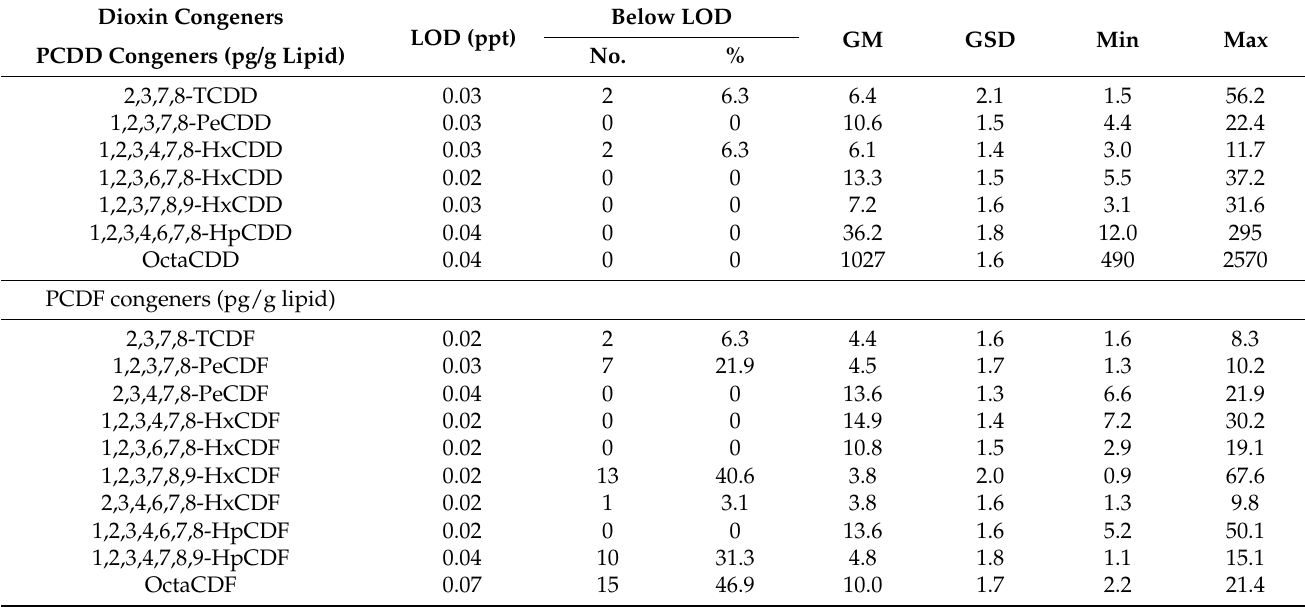
Table 1. Dioxin and non-ortho-PCB levels in blood ( n =